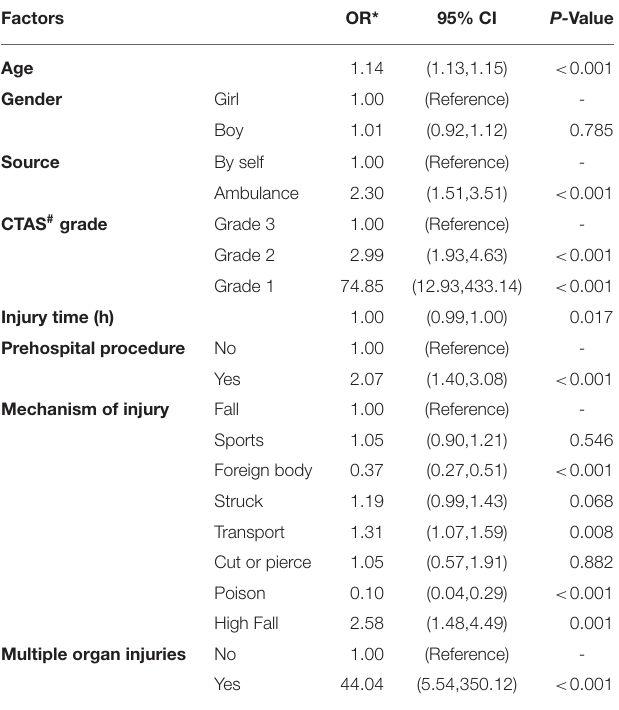
TABLE 5 | Risk factors of admission in hospital among child unintentional injury patient in the emergency